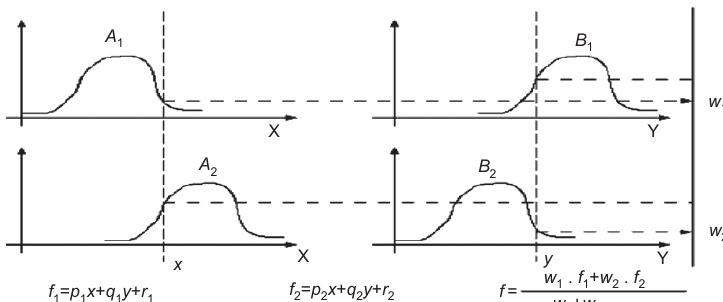
Figure 5. Rules of Sugeno Model.